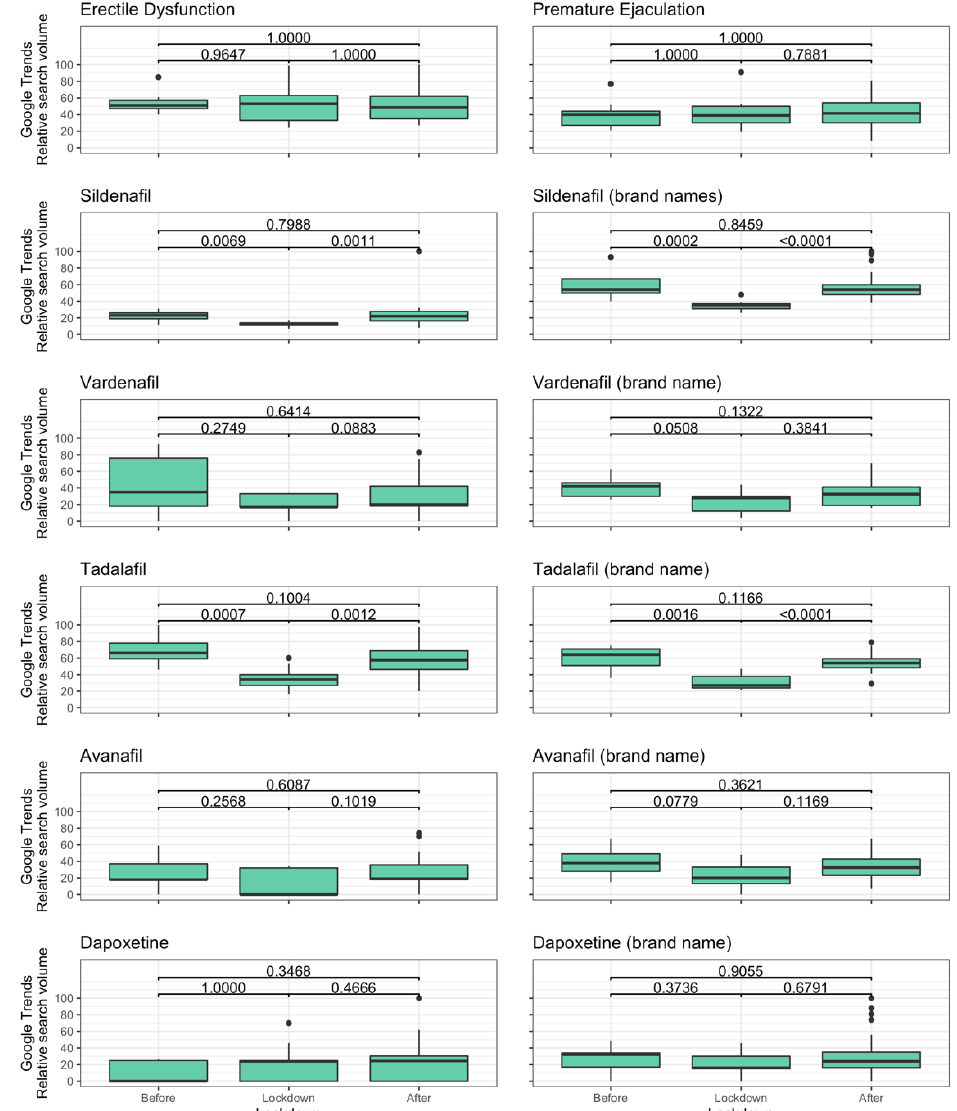
Figure 1. Changes in Google Trends relative search volume for the different keywords pertaining to male sexual health.